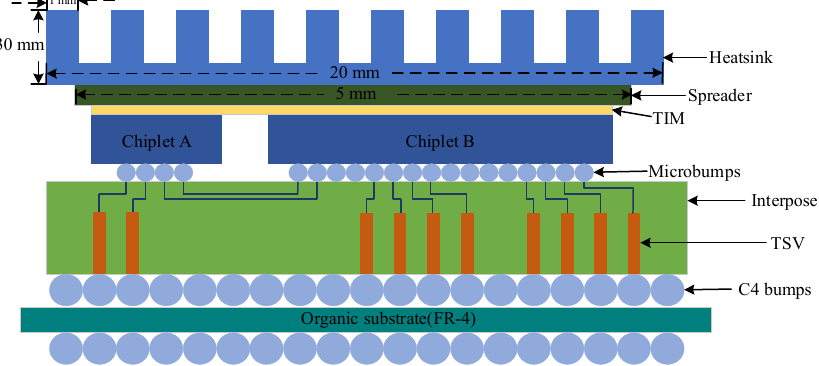
Figure 1. Schematic of 2.5-D system with passive interposer.